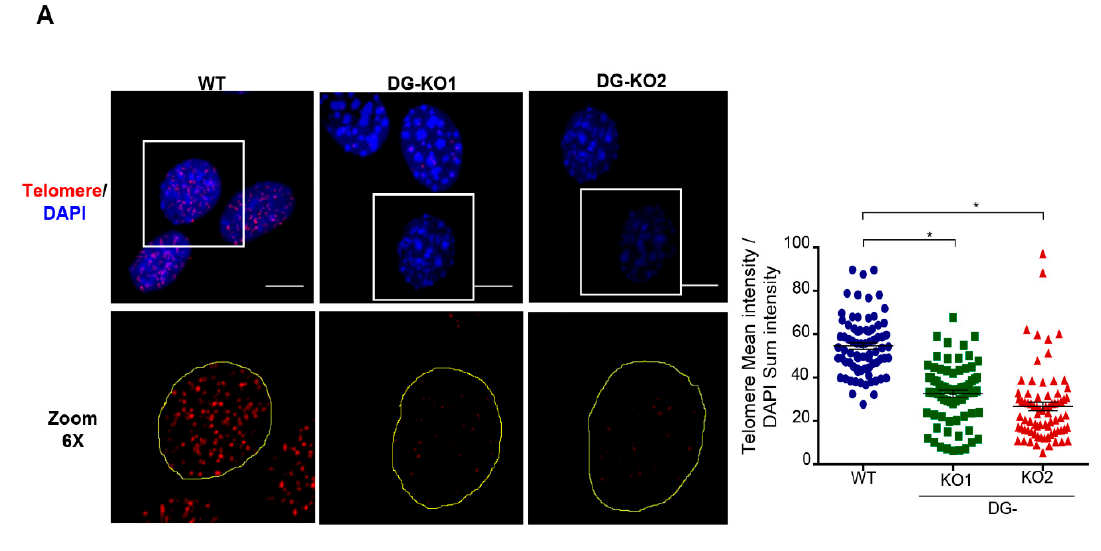
Figure 8. DG-KO cells exhibit telomere shortening. ( A )WT, DG-KO1 and DG-KO2 cells grown on coverslips were processed for FISH using a specific telomere probe (see Methods), and nuclei were decorated by staining with DAPI. Representative CLSM images are shown; bar, 10 µM. The right graph shows the relative telomere length determined by the telomere mean intensity divided by DAPI sum intensity. Significant differences were determined by non-parametric Kruskal–Wallis tests, followed by post hoc Dunn´s analysis. Data indicate the mean ± SEM from three separate experiments ( n = 75 cells per cell culture); * p < 0.05 compared to WT).